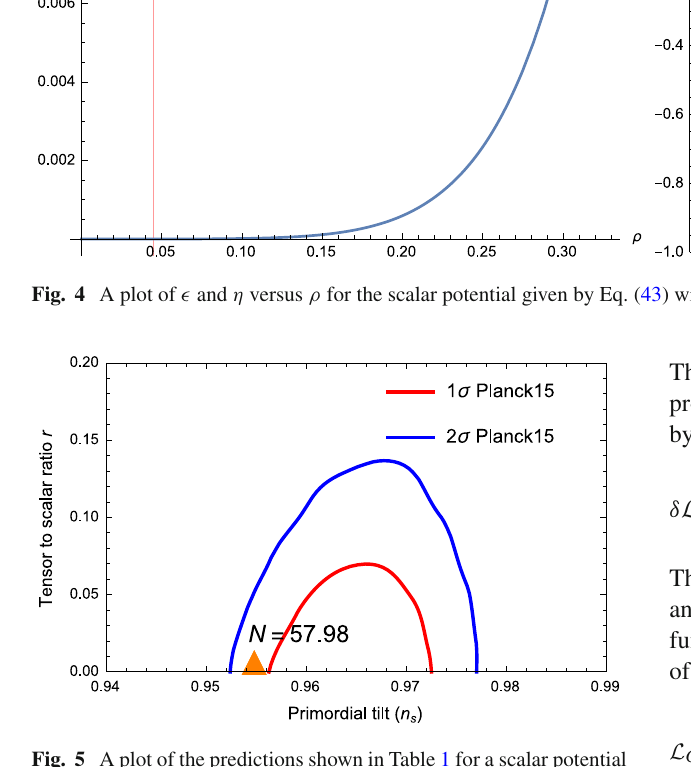
Fig. 5 A plot of the predictions shown in Table 1 for a scalar potential in Eq. (43) with correction term Eq. (44), in the n s − r Planck ’15 results for TT,TE,EE,+lowP and assuming (cid:9) CDM +